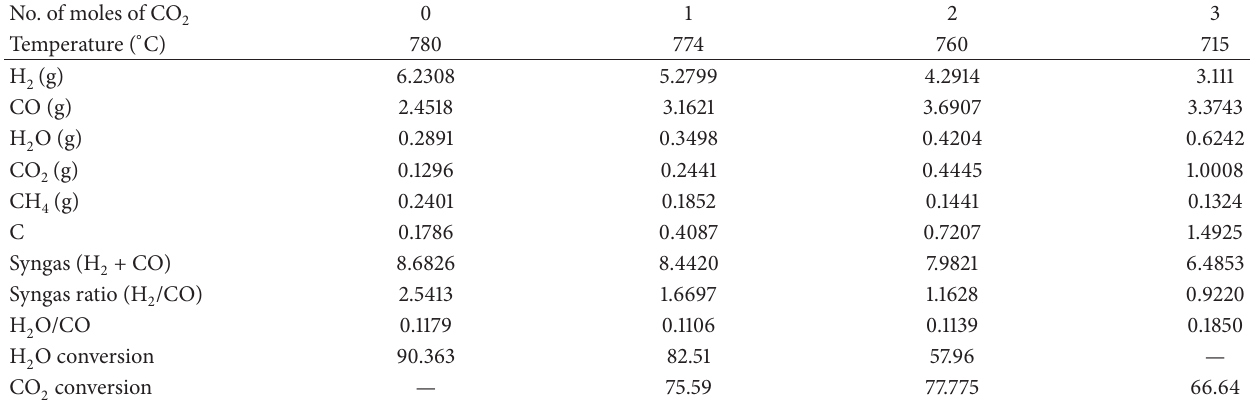
Table 3: Optimum parameters in combined reforming of propane at case OxPR = 3.